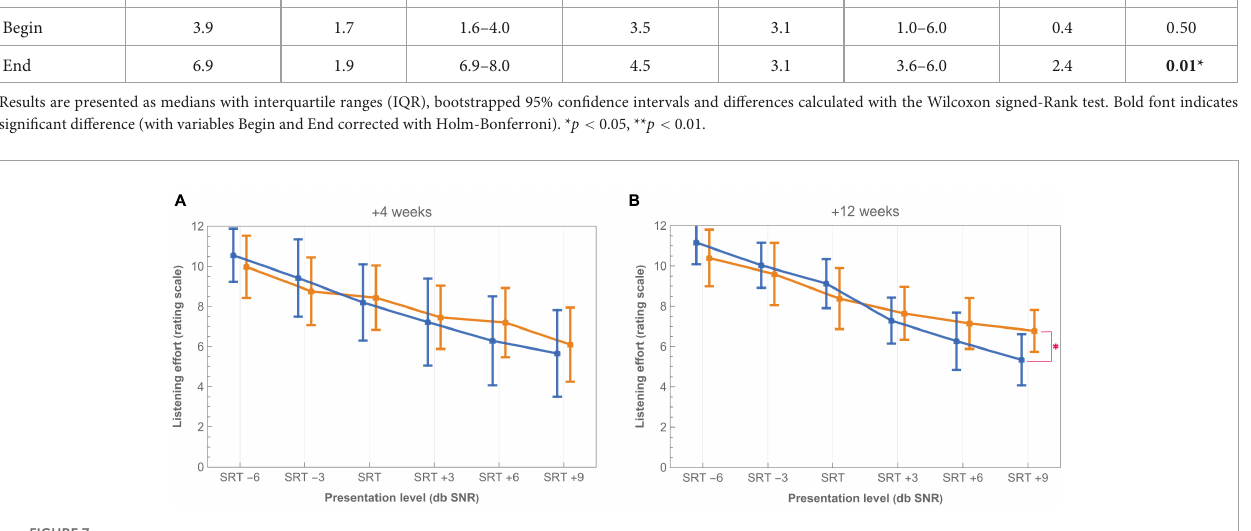
FIGURE7 Listening effort in noise with imaging-based (orange − ) and standard (blue − ) fitting at (A) +4 weeks and (B) +12 weeks from CI activation. Scores presented are mean ratings on a scale of 0 (no effort) to 12 (extreme effort). Listening conditions are offset on the X-axis to improve readability. Tested levels of SRT –6, SRT –3, SRT, SRT +3, SRT +6, and SRT +9 are expressed relative to the participant’s individual SRT on corresponding conditions (control or test). Asterisk (*) denotes p < 0.05 significant difference after applying Holm-Bonferroni correction. Bars indicate 95% confidence